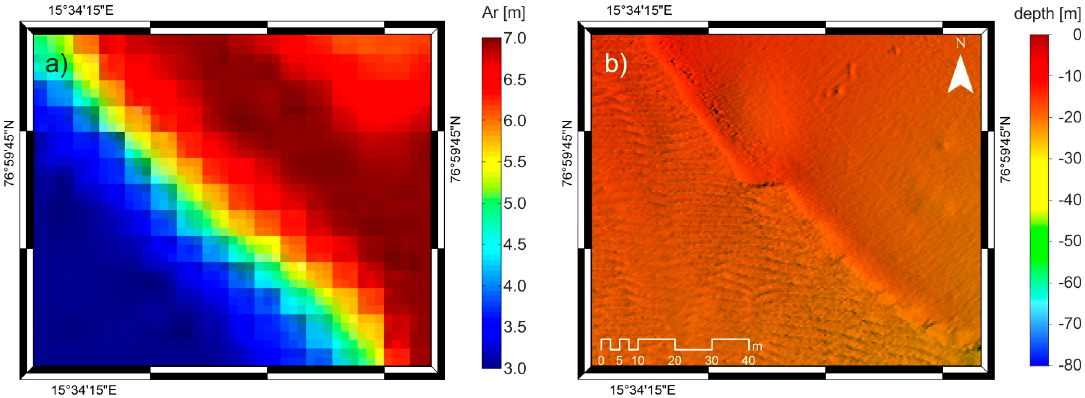
Figure 12. Autocorrelation length ( a ) and DEM of 108 × 89 m area selected from the central part of